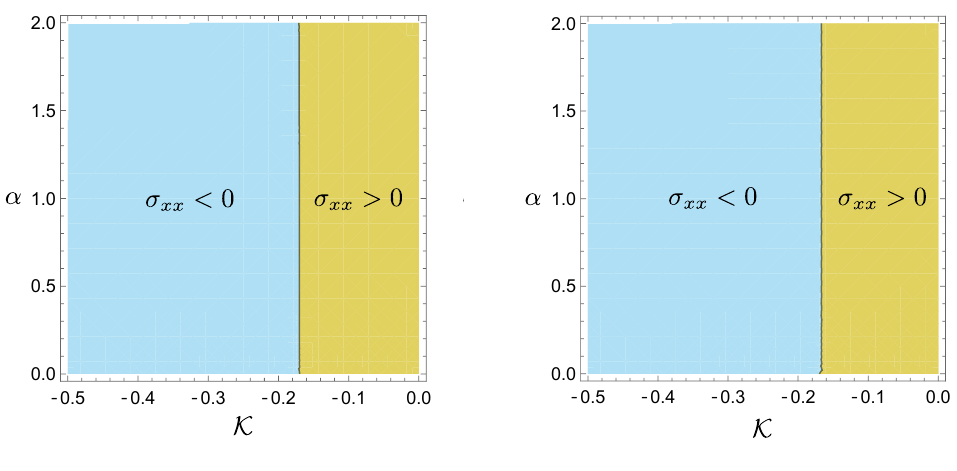
Figure 5 . Distribution of the sign of (cid:27) xx as a function of the disorder strength (cid:11) and the coupling constant K for the Linear model. The left plot is for ( T = 0 ; B = 10) and the right one for ( T = 0 ; B = 1000). (cid:27) xx becomes negative in blue regions. To avoid a negative longitudinal conductivity, the value of K should not be less than (cid:0) 1 = 6.